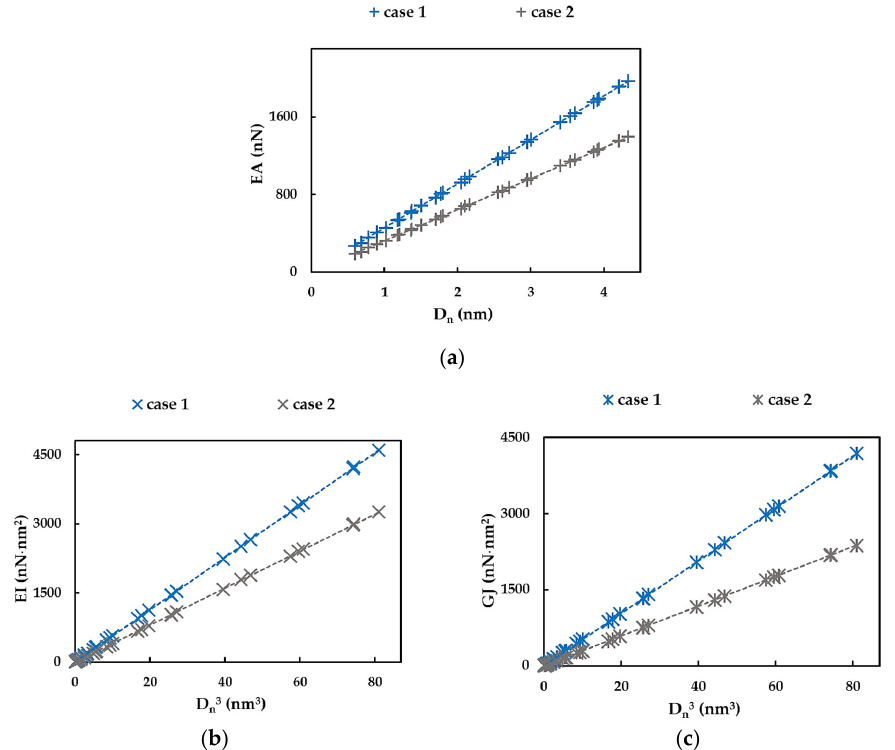
Figure 10. Evolutions of: ( a ) tensile, EA, rigidity with D n and ( b ) bending, EI, and ( c ) torsional, GJ, rigidities with D n3 for the SWInNNTs in Table 4.